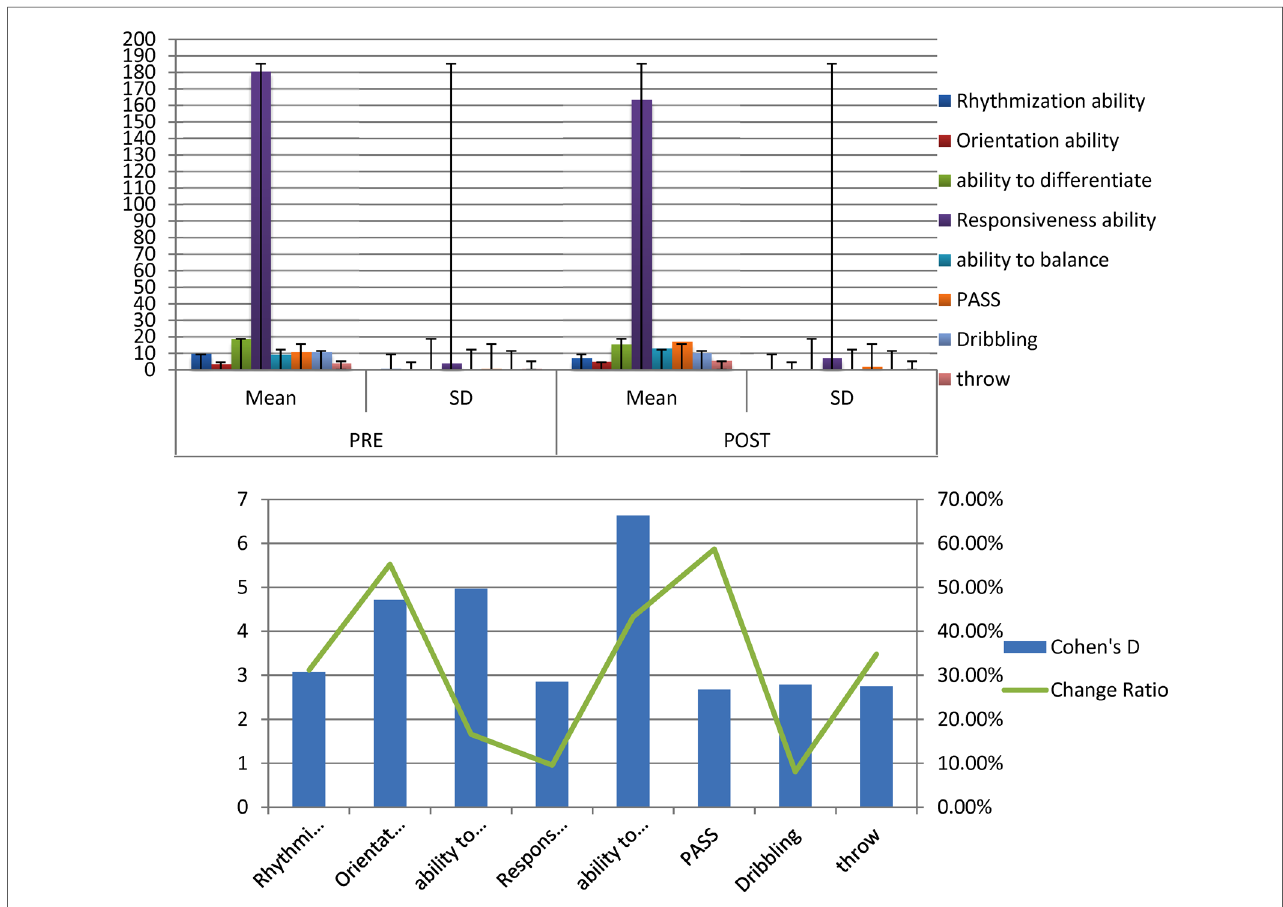
FIGURE 3 Indication of differences between the averages of pre and post measurements of the controlled group in the variables under